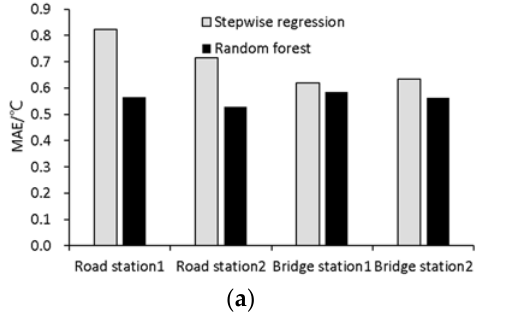
Figure 10. MAE ( a ) and RMSE ( b ) for the stepwise regression and random forest model (gray bar: stepwise regression, black bar: random forest model).